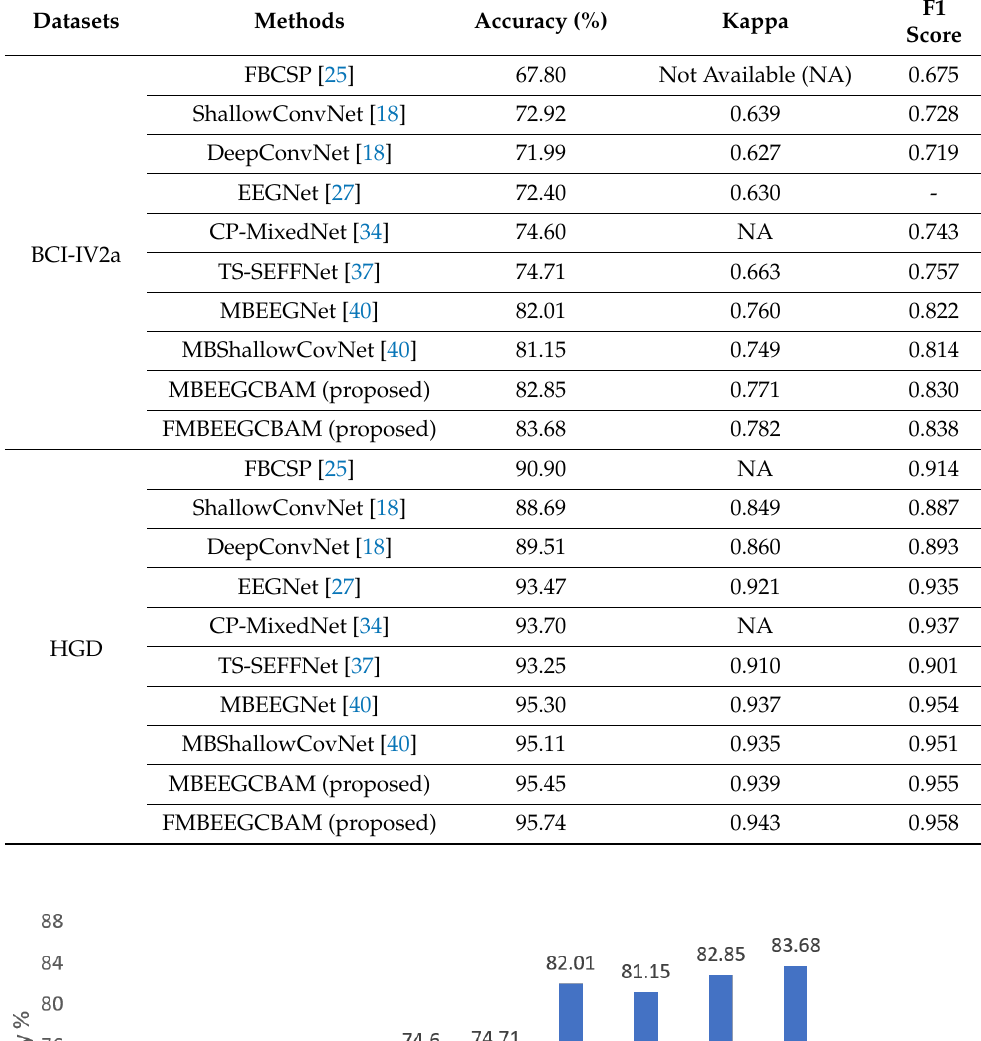
Table 2. The comparison summary of classification performance in proposed models.